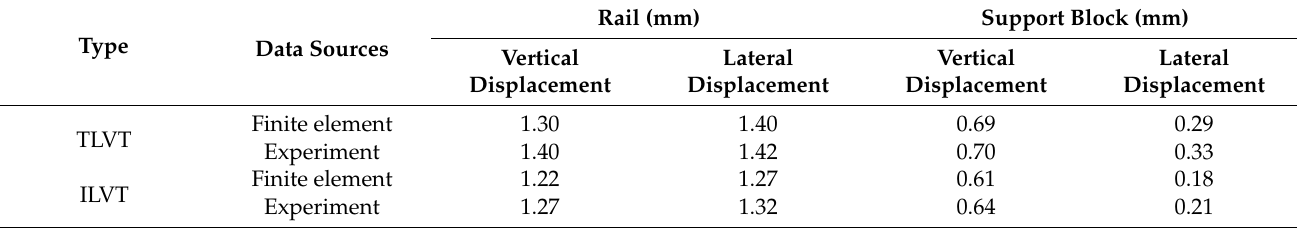
Table 4. Comparative analysis of geometric shape from Finite element and Experiment.